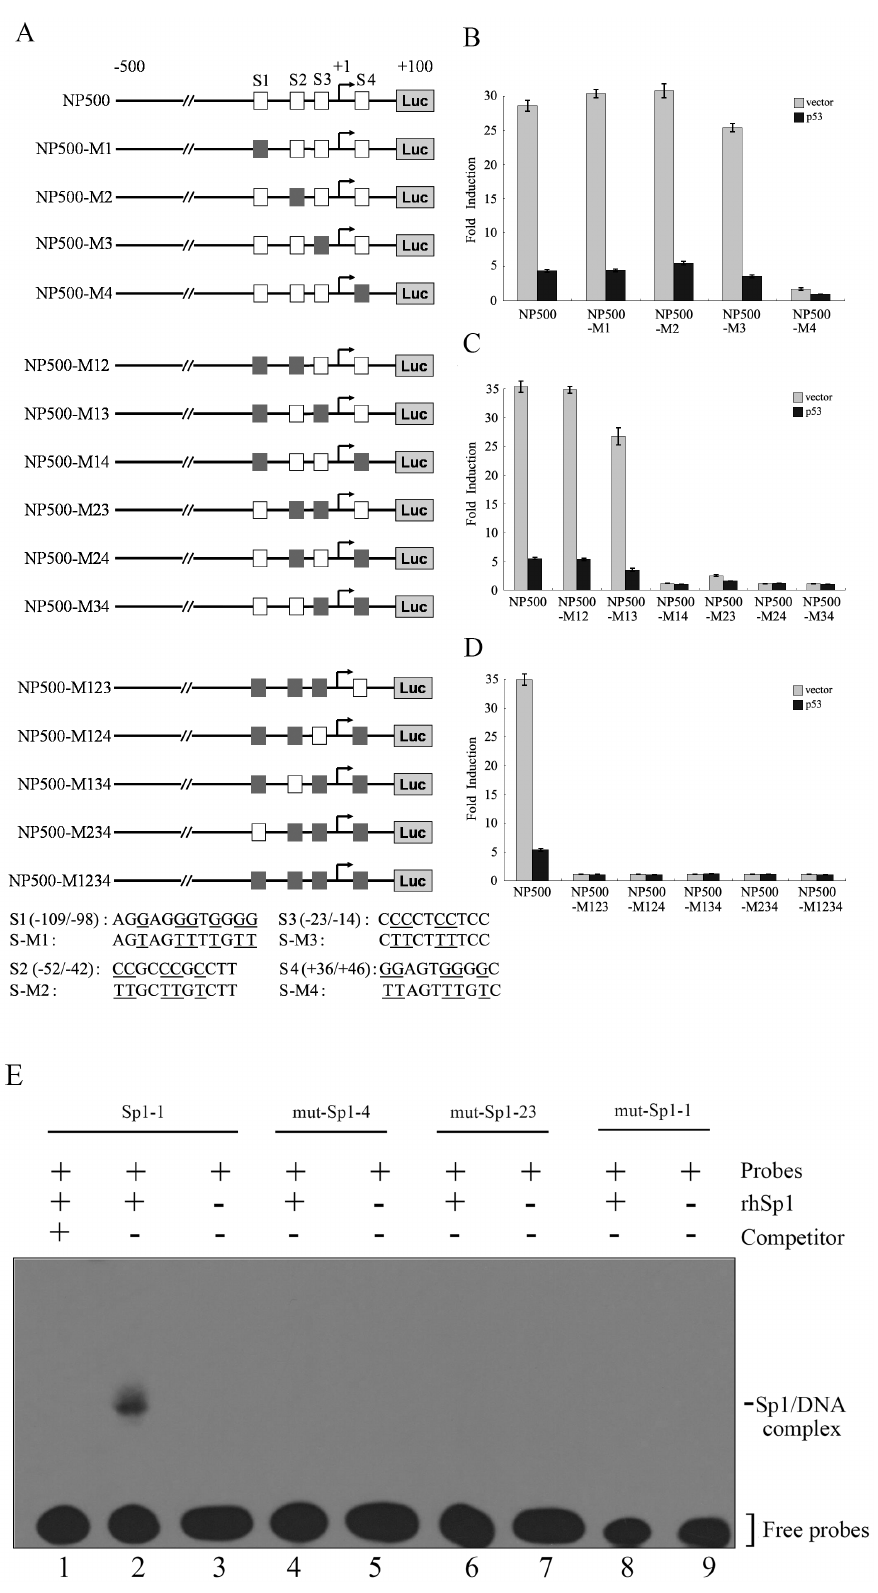
Figure 6. Sp1-binding sites mutations abrogate the repression of RLIM promoter by p53. ( A ) Schematic representation of the RLIM promoter luciferase reporter construct NP500-Luc and various mutated constructs with the Sp1 binding sites mutations (NP500-M1 to NP500-M1234). The four Sp1 binding sites S1 to S4 (wild type denoted as % and mutations denoted a & ) are shown. The sequences of the Sp1 binding sites are shown in the lower panel with the mutated sites underlined. ( B–D ) Cotransfection was performed as described in Figure. 5B using NP500-Luc and